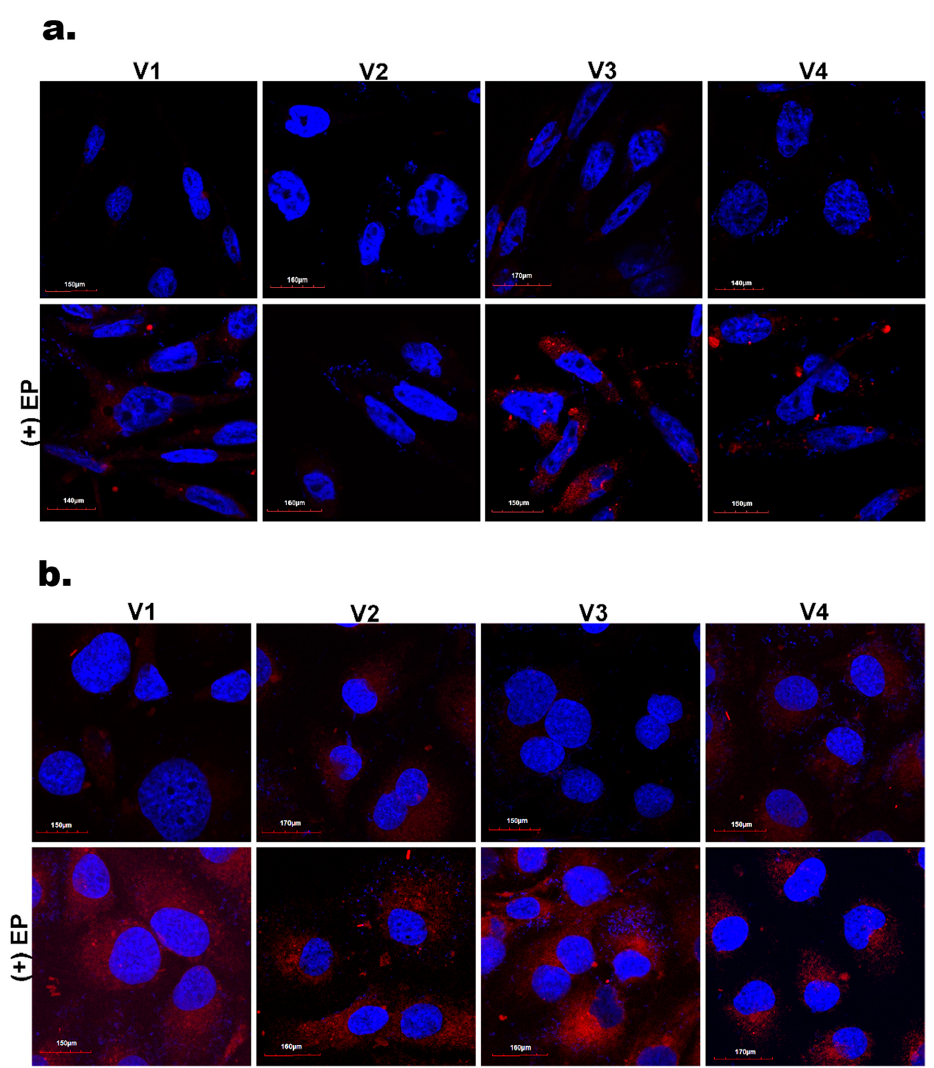
Figure 5. Intracellular distribution of nanosystems after 24 h incubation with NCs (upper panel) or 10 min exposition to NCs after EP (lower panel) in ( a ) CHO-K1 cells and ( b ) SKOV-3 cells.